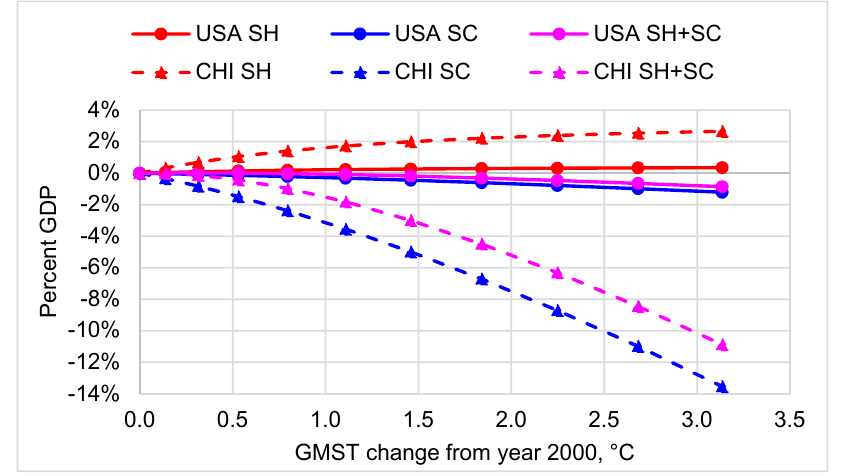
Figure 13. USA and CHI heating, cooling and heating plus cooling economic impact (percent of GDP) versus GMST change from 2000, with non-temperature drivers constant at 2010